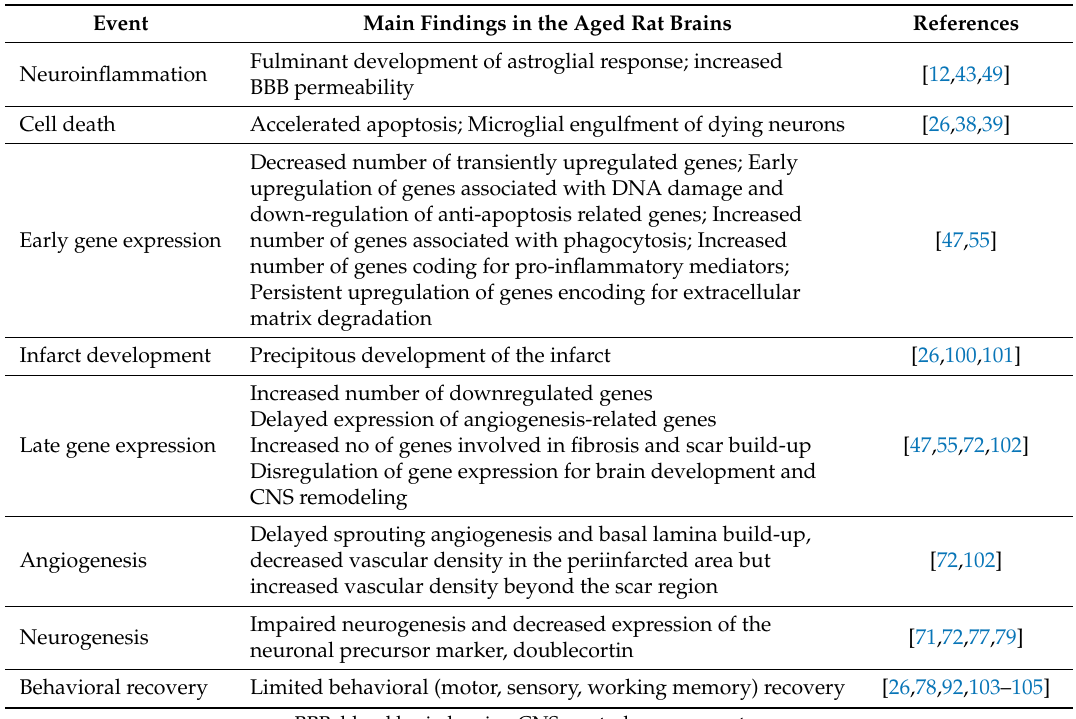
Table 1. Summary of cellular and molecular events after focal ischemia in the aged rat brains as compared to the young post-stroke rat